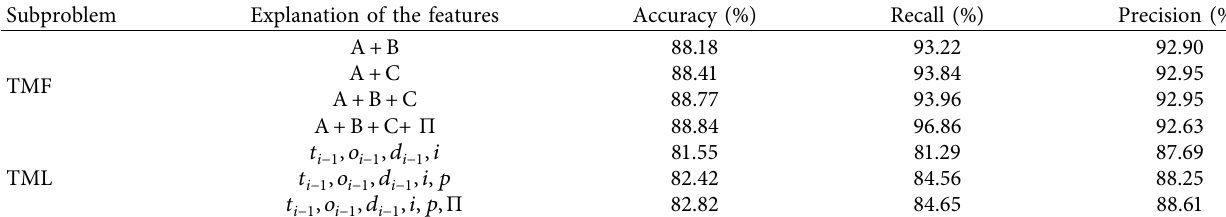
Table 3: The performance of trip-making prediction.